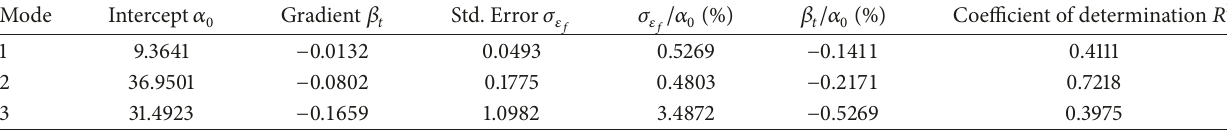
Table 2: Coefficients of linear regression model (frequency ∼ temperature) of girder No. 1.